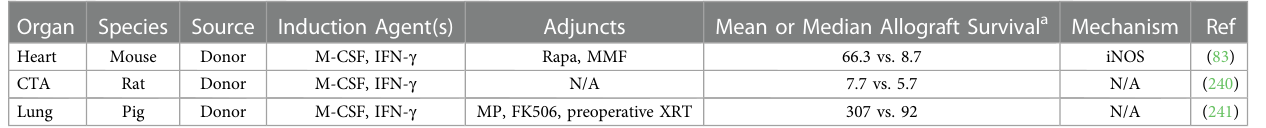
TABLE 3 Studies of Mregs in animal